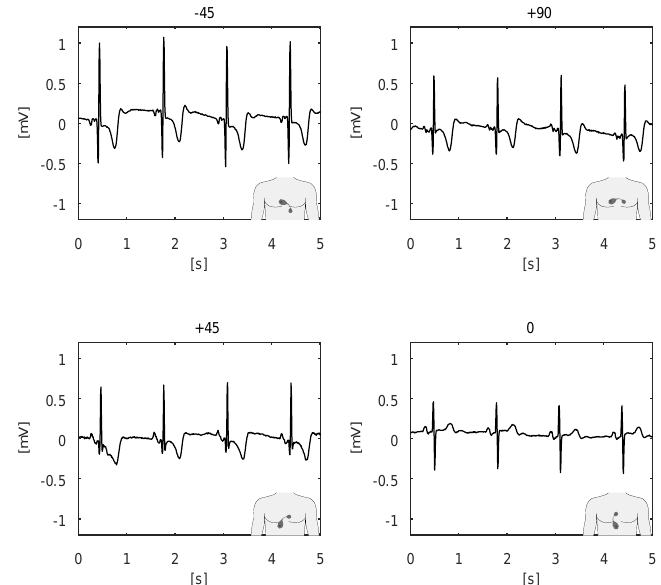
Figure 8. Raw ECG signals recorded in four positions, obtained by rotating the sensor from the vertical position shown in Figure 6, for − 45 ◦ , 45 ◦ , 90 ◦ , and 0 ◦